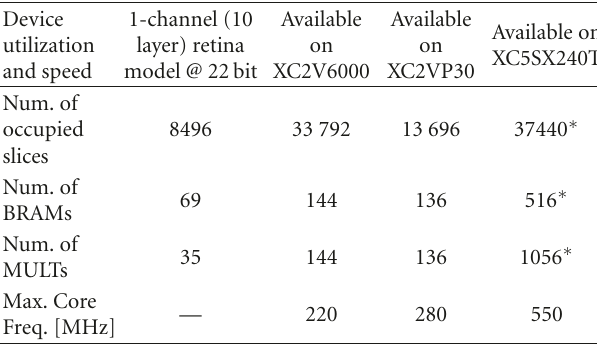
Figure 5: Structure of the optimized arithmetic unit to compute the Gauss-type template (pipeline registers are not shown for simplicity).